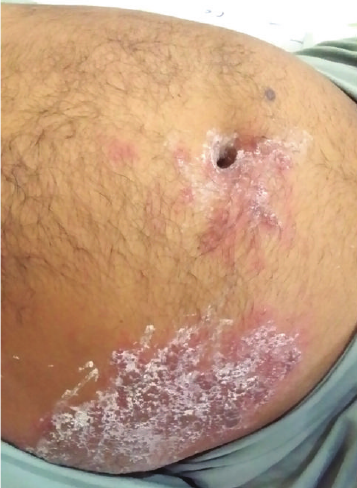
Figure 1: Distended abdomen with vesicular eruption involving the right T8–T11 dermatomes.